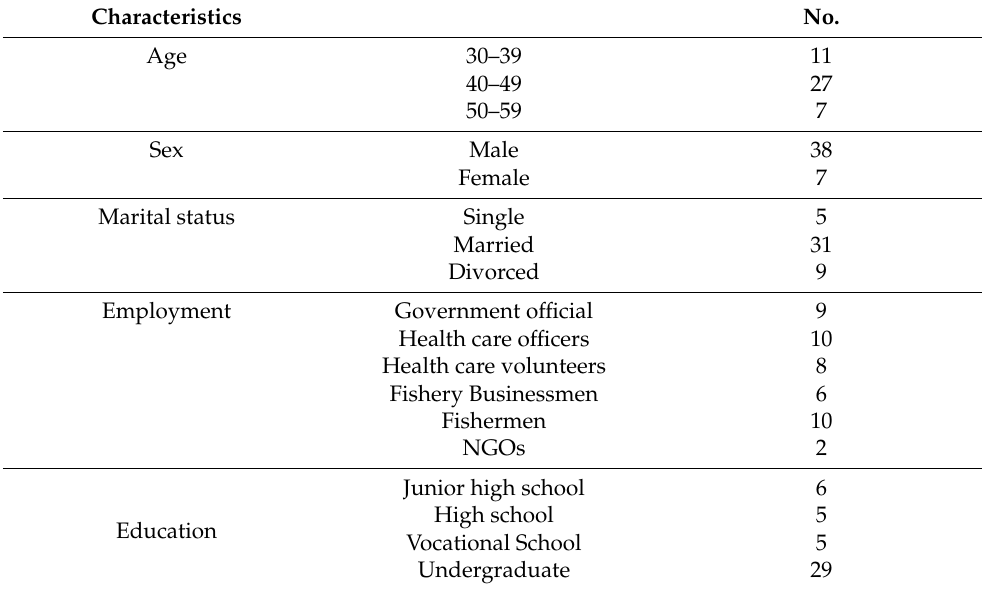
Table 1. Socio-demographics of the participants (n =